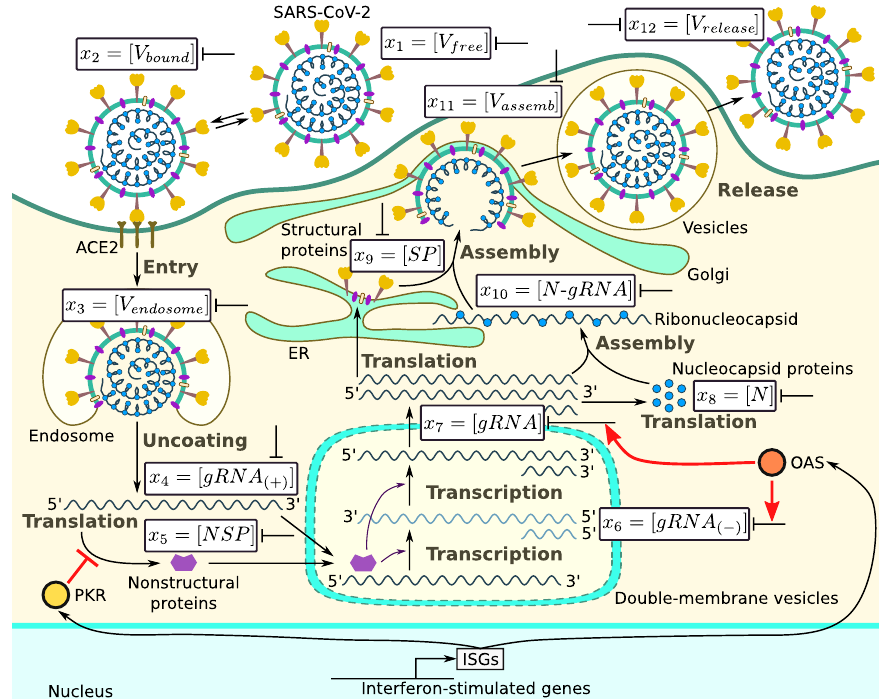
Figure 1. Biochemical scheme of the SARS-CoV-2 replication cycle. Targets of type I IFN-mediated inhibition of virus replication are